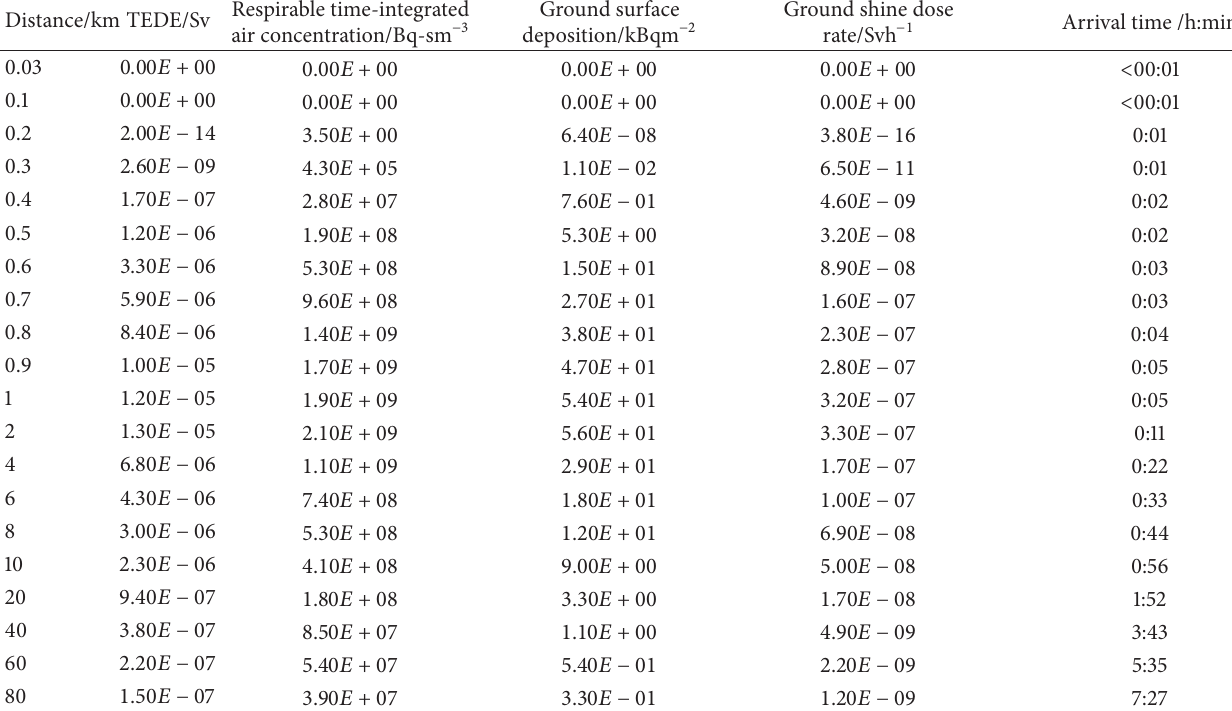
Table 2: Downwind distance and other plume parameters at different arrival time intervals.